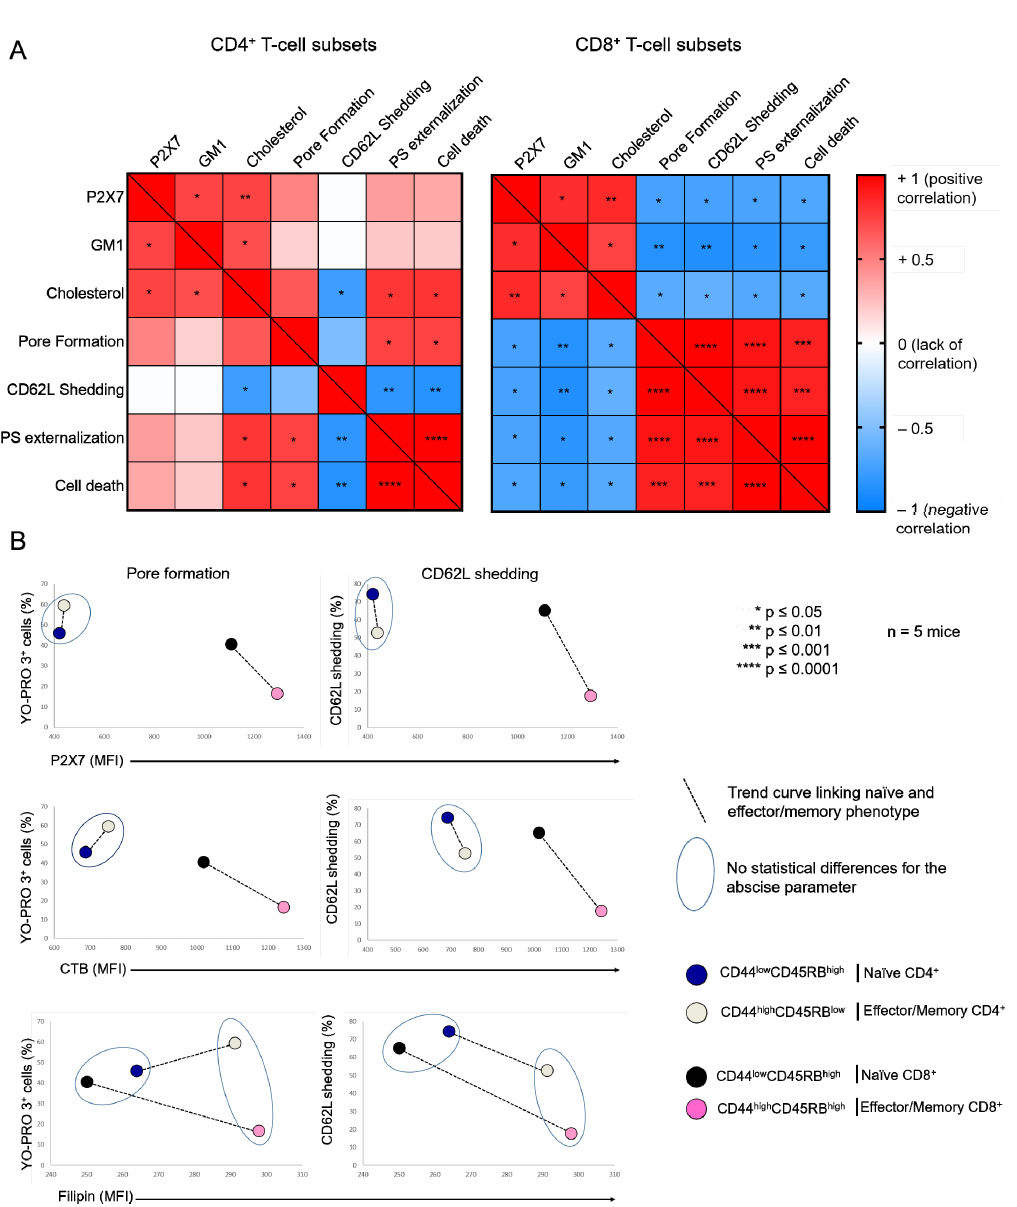
Figure 2. Relationship between the plasma membrane levels of GM1, cholesterol, and P2X7, and cellular responses induced by eATP in T-cell subsets . ( A ) Pearson correlation matrix showing the degree of correlation between the plasma membrane levels of GM1, cholesterol, and P2X7, pore formation, CD62L shedding, PS externalization and cell death in CD4 + and CD8 + T-cell subpopulations in the presence of 500 µ M ATP for 30 min at 37 ◦ C. The magnitude and direction of the correlation coefficient is indicated on a color gradient that varies from +1 (positive correlation) to − 1 (negative cor- relation). White squares indicate the absence of a correlation. Red and blue squares represent positive and negative correlations between two variables, respectively. Statistically significant correlations are denoted by asterisks within squares: * p ≤ 0.05, ** p ≤ 0.01, *** p ≤ 0.001, **** p ≤ 0.0001. ( B ) Scatter plots showing the phenotypic profile of CD44 low CD45RB high naïve and CD44 high CD45RB low or CD44 high CD45RB high effector/memory T-cell subsets (either CD4 + or CD8 + ) in terms of the ampli- tude of ATP-induced pore formation and CD62L shedding (500 µ M, 30 min, 37 ◦ C) and the plasma membrane levels of GM1, cholesterol, and P2X7. The T-cell subsets that were non-statistically differ- ent for the abscissa parameter (either GM1, cholesterol, or P2X7 expression) are surrounded by a blue ellipse. The black dotted line links the naïve subset (either CD4 + or CD8 + ) with its effector/memory counterpart. Data are expressed as the mean of percentages (n ≥ 5